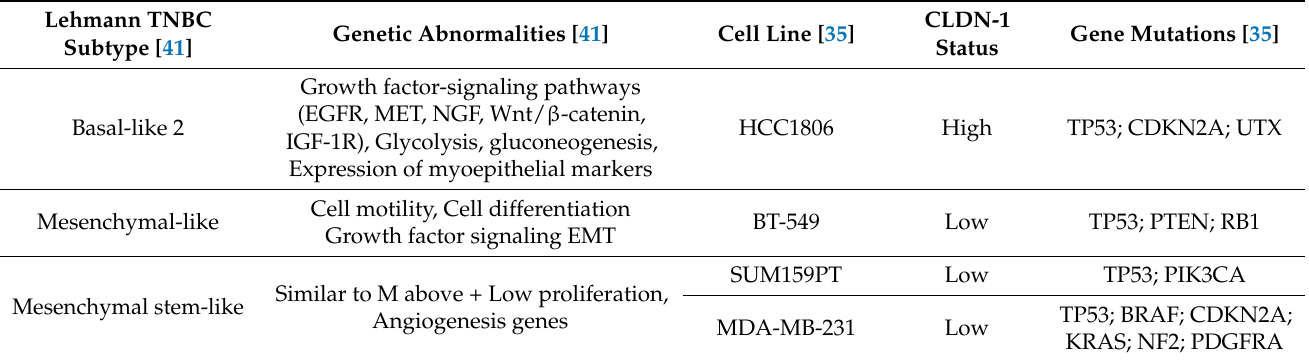
Table 1. Characterization of Cell Lines used in this study